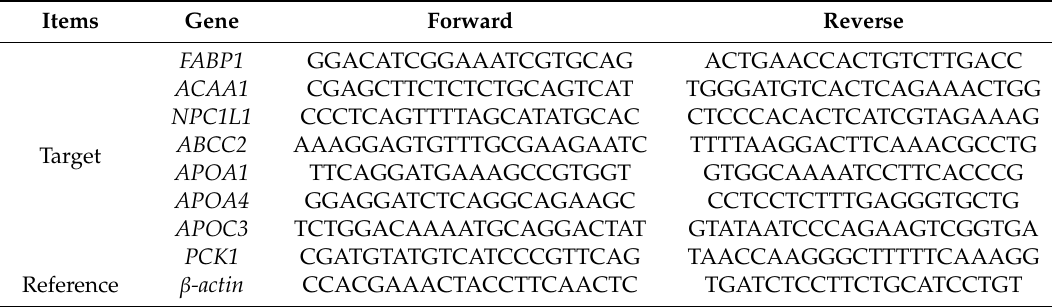
Table A1. Description of primers used in the RT-qPCR analysis of gene